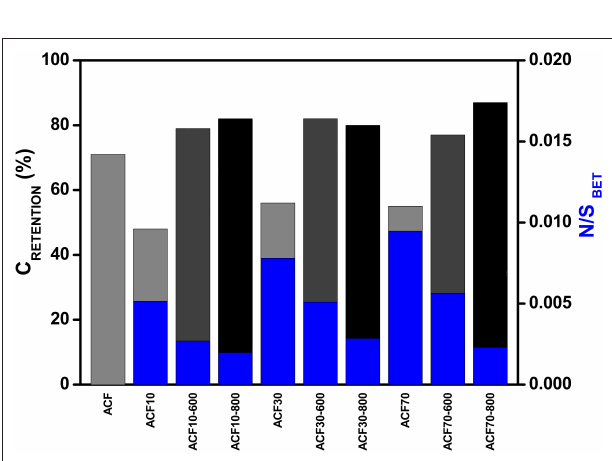
FIGURE 2 | Effect of the nitrogen amount on the capacitance retention